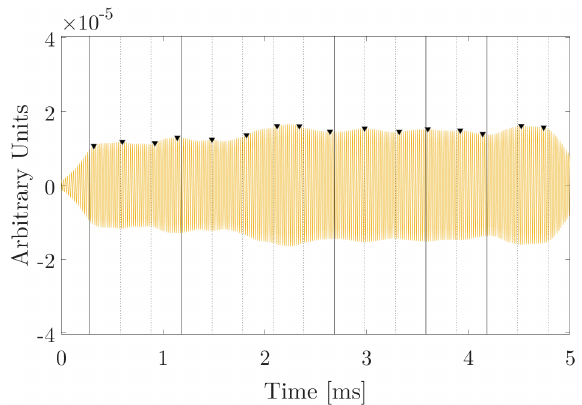
Figure 7. Correlation analysis. Cross-correlations between the received signal and the expected 1 bit of 50 kHz, at 300 µ s duration per bit. This received signal is the same for bit 0.